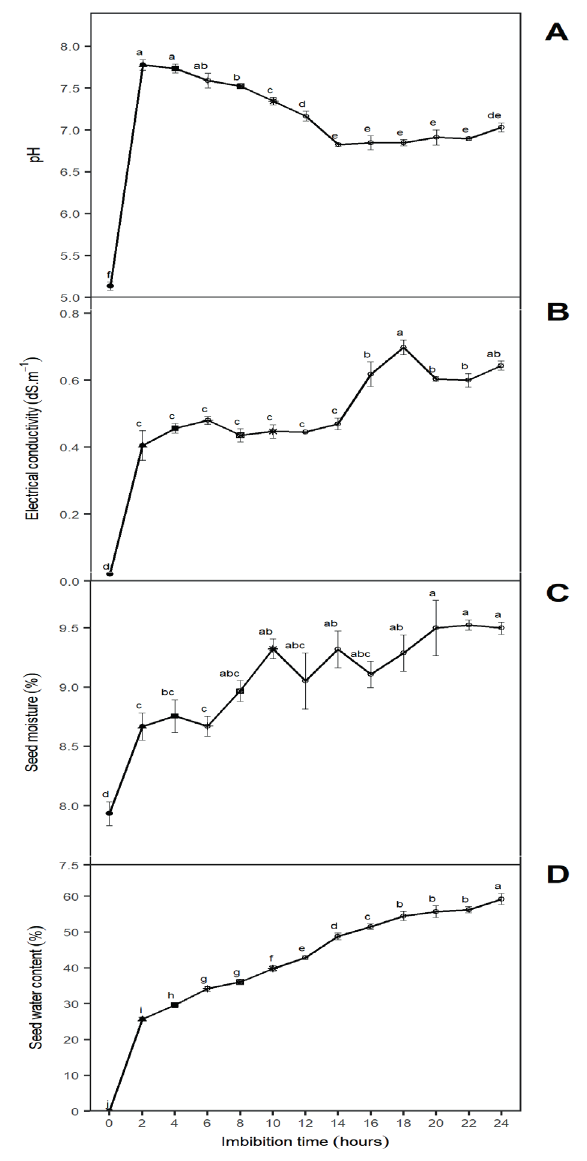
Figura 1. Response of Jatropha curcas seeds after different imbibition time. (A) pH; (B) Electrical conductivity; (C) Seed moisture and (D) Seed water content. The letter represent the mean difference with Student-Newman- Keuls test (p = 0.05). Means are represent with (±SE). n =